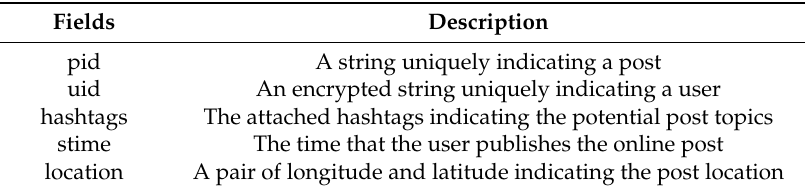
Table 1. Description of social media post field.